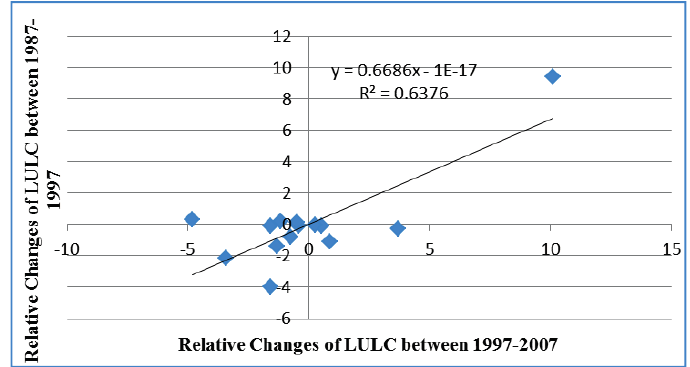
Figure 5. Correlation between relative changes of LULC in 1987–1997 and relative changes of LULC in